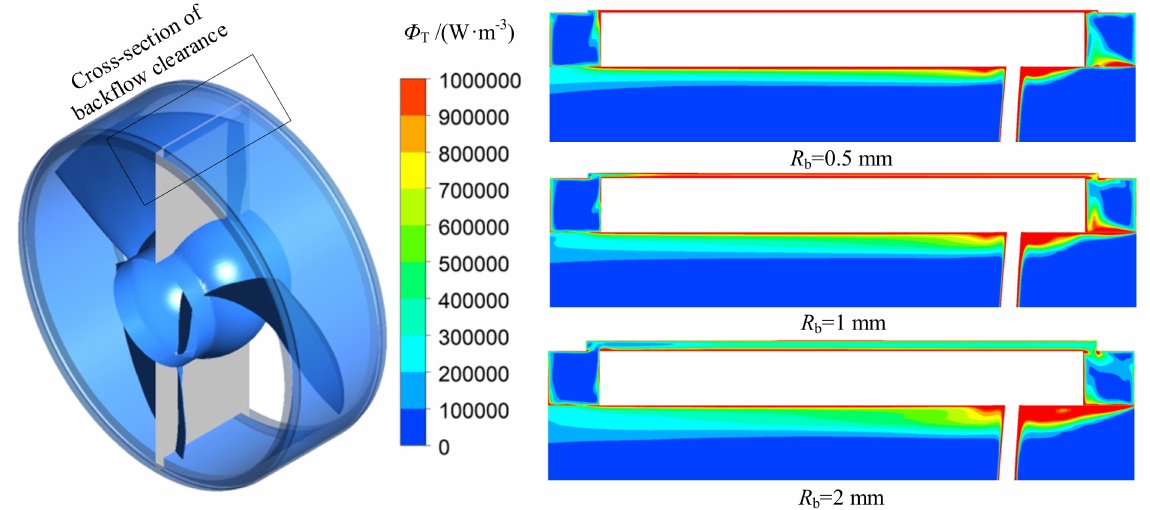
Figure 15. Distribution of total dissipation rate in cross-section of different backflow clearance at 1.0 Q des .